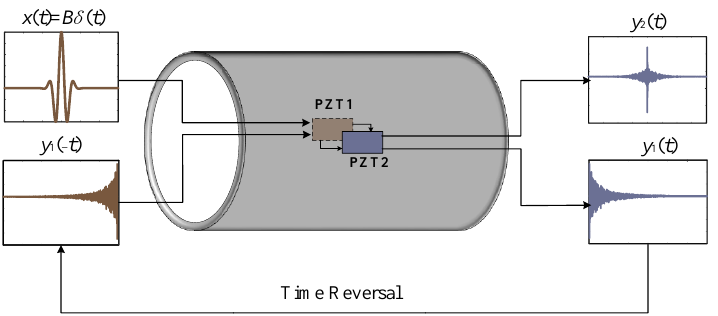
Figure 1. Time reversal process.